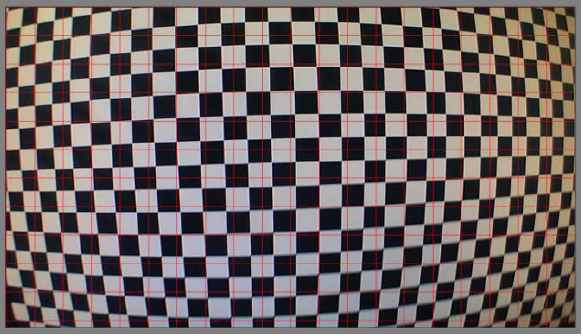
Figure 1. Effect of the image distortion of a chessboard on a regular grid (indicated by the red lines)